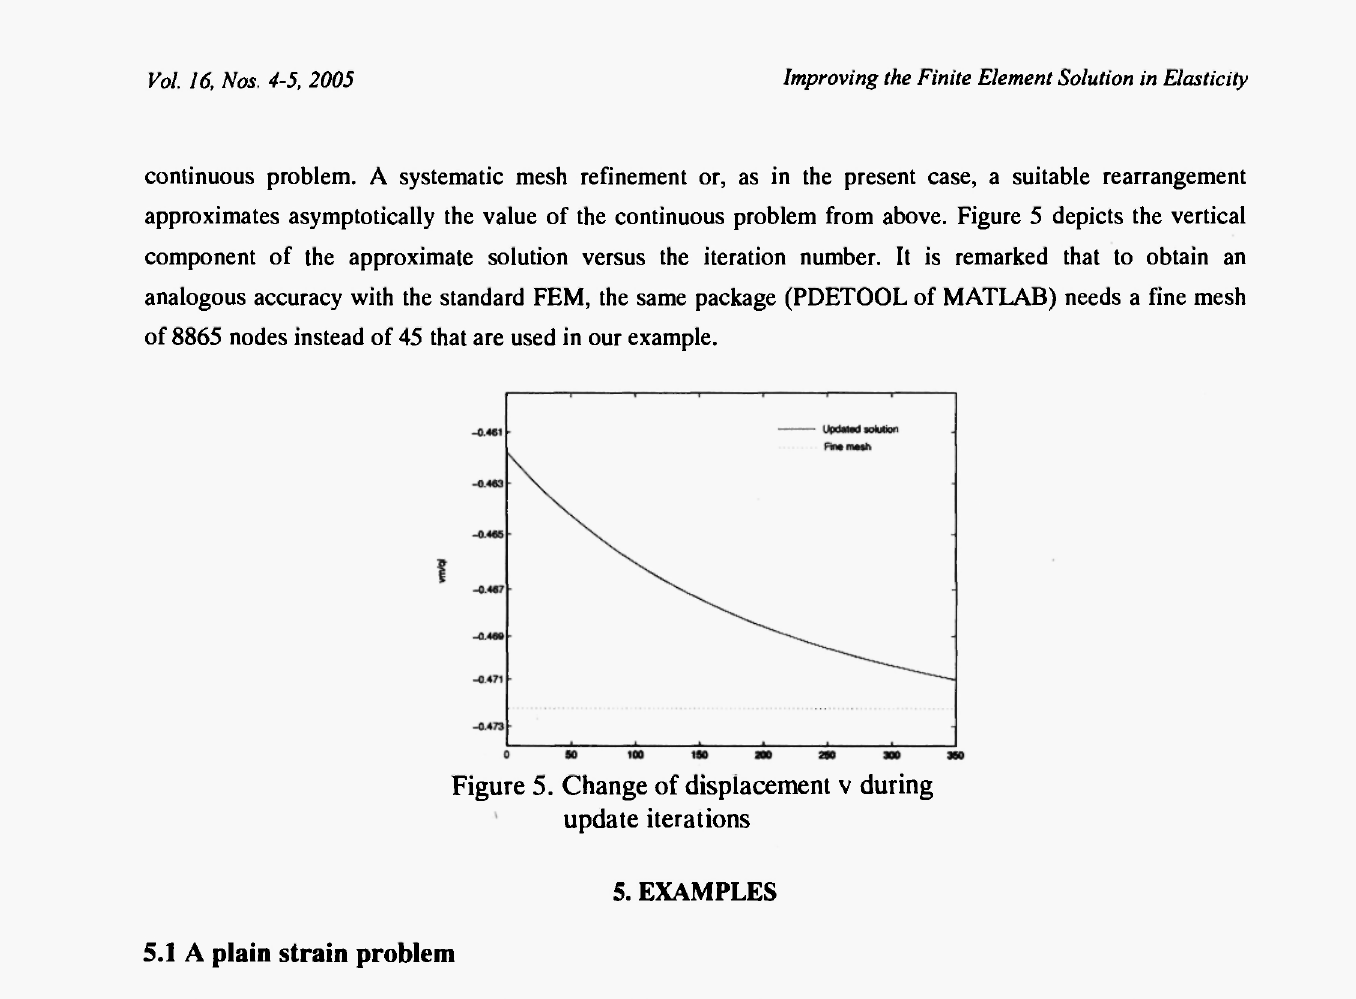
Figure 5. Change of displacement ν during update iterations